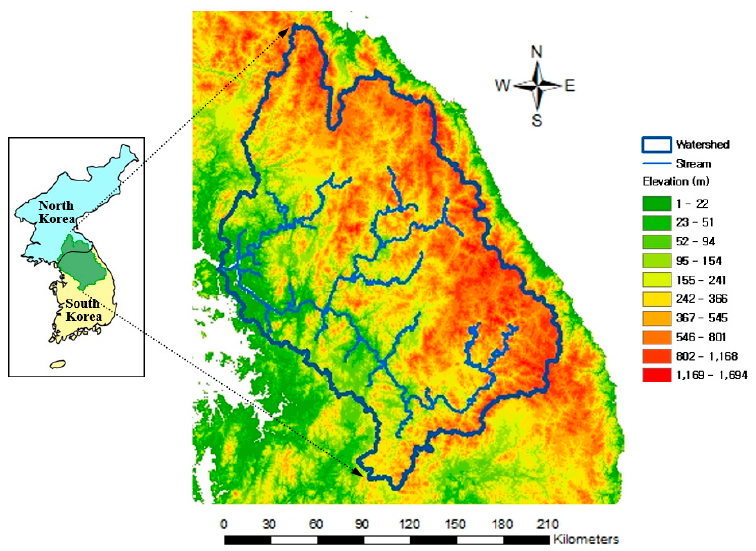
Figure 1. Map of the Han River basin.